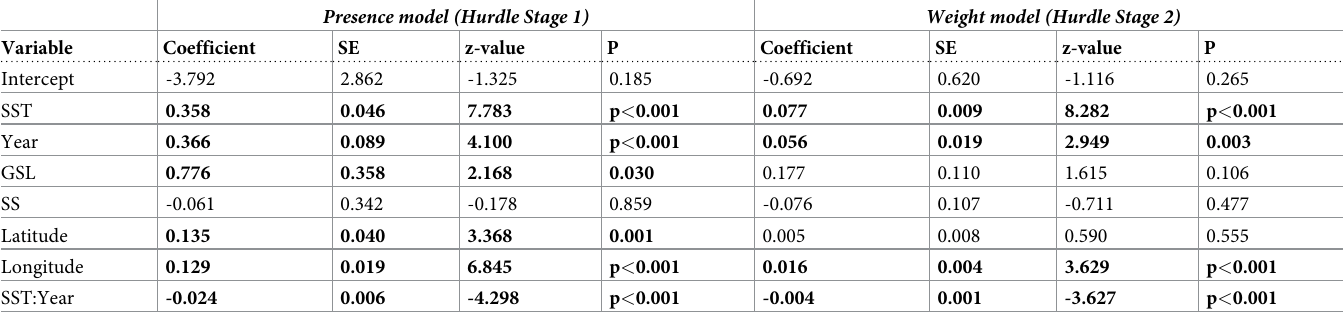
Table 2. Statistical